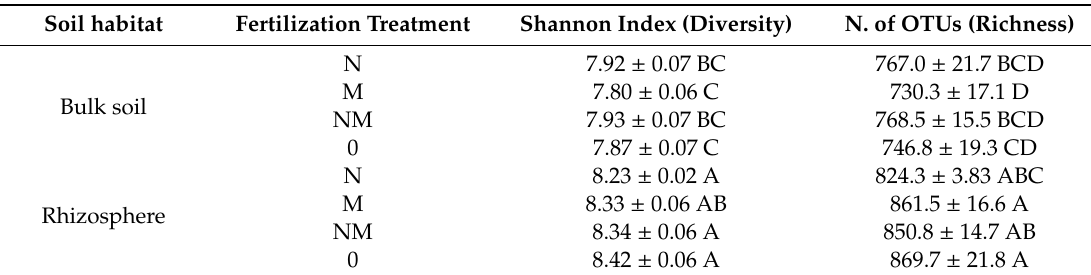
Table 1. Alpha-diversity metrics of the soil bacterial microbiota, calculated at Operational taxonomic unit (OTU 97 ) level, in the two soil habitats, under the four N-fertilization treatments. Di ff erent letters indicate significantly di ff erent means (Tukey HSD, p < 0.05).